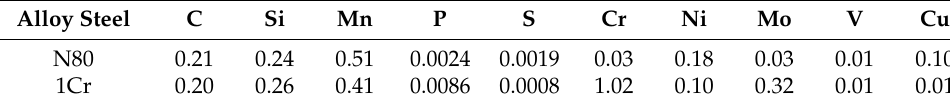
Table 1. Chemical composition of test samples (% by weight).